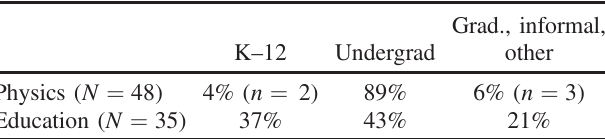
TABLE II. PER graduate students ’ primary areas of research (values are the percentage of the subgroup populations).